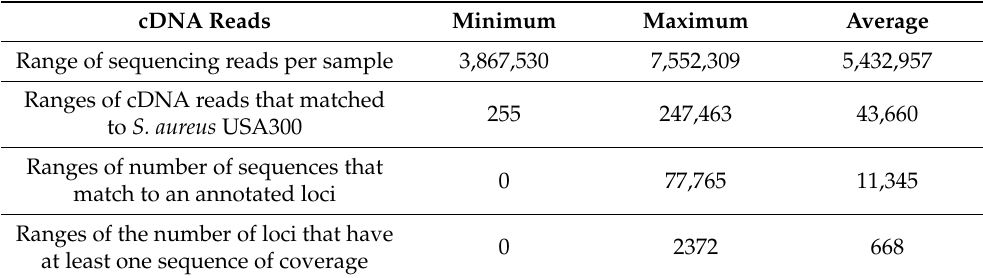
Table 1. Number of cDNA reads at different steps of data processing .